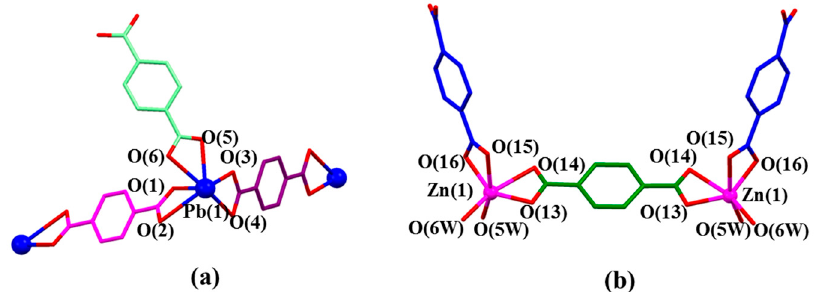
Figure 2. ( a ) Coordination mode of Pb(1) metal and surrounding O donors in the single crystal